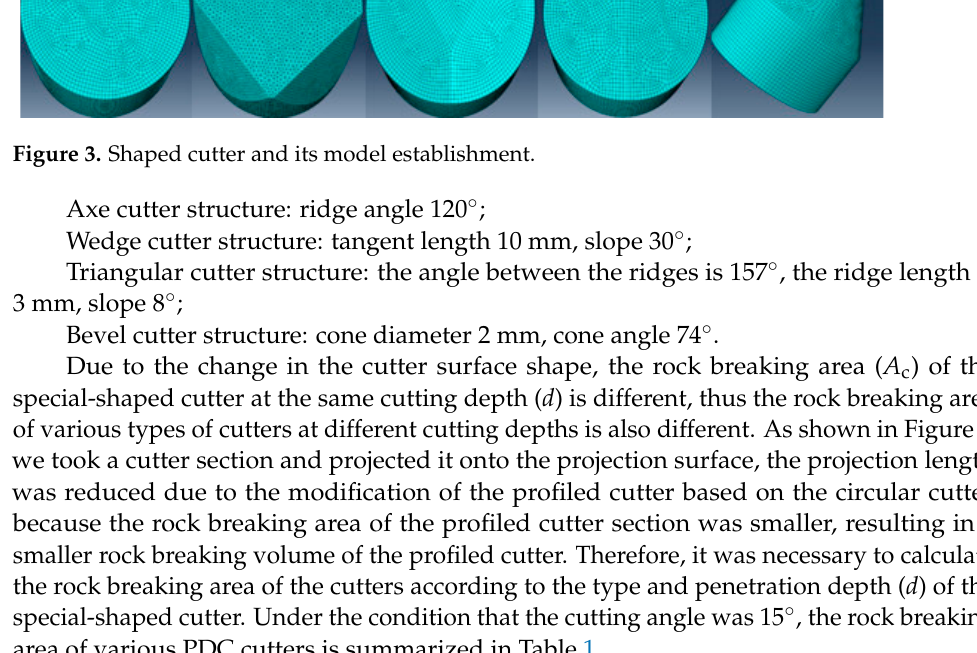
Table 1. Statistical table of the change in rock breaking area of the PDC cutters with the penetration depth.